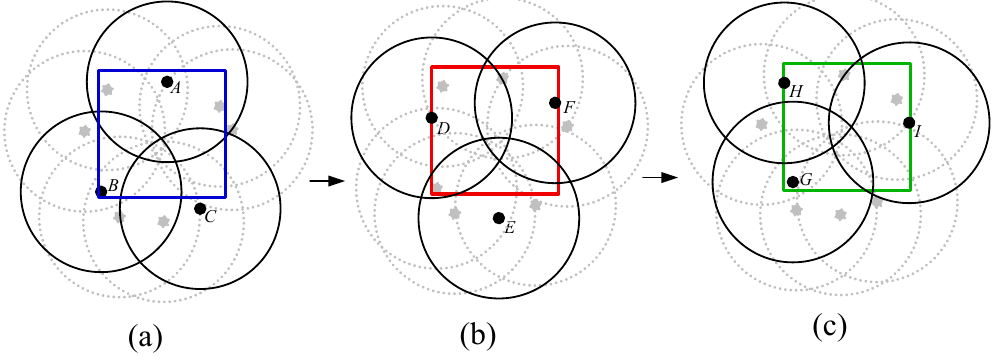
Figure 3. An illustration of PSKGS sleep scheduling for K = 1 by group of sensors. ( a ) A , B , and C ; ( b ) D , E , and F ; ( c ) H , I , and G